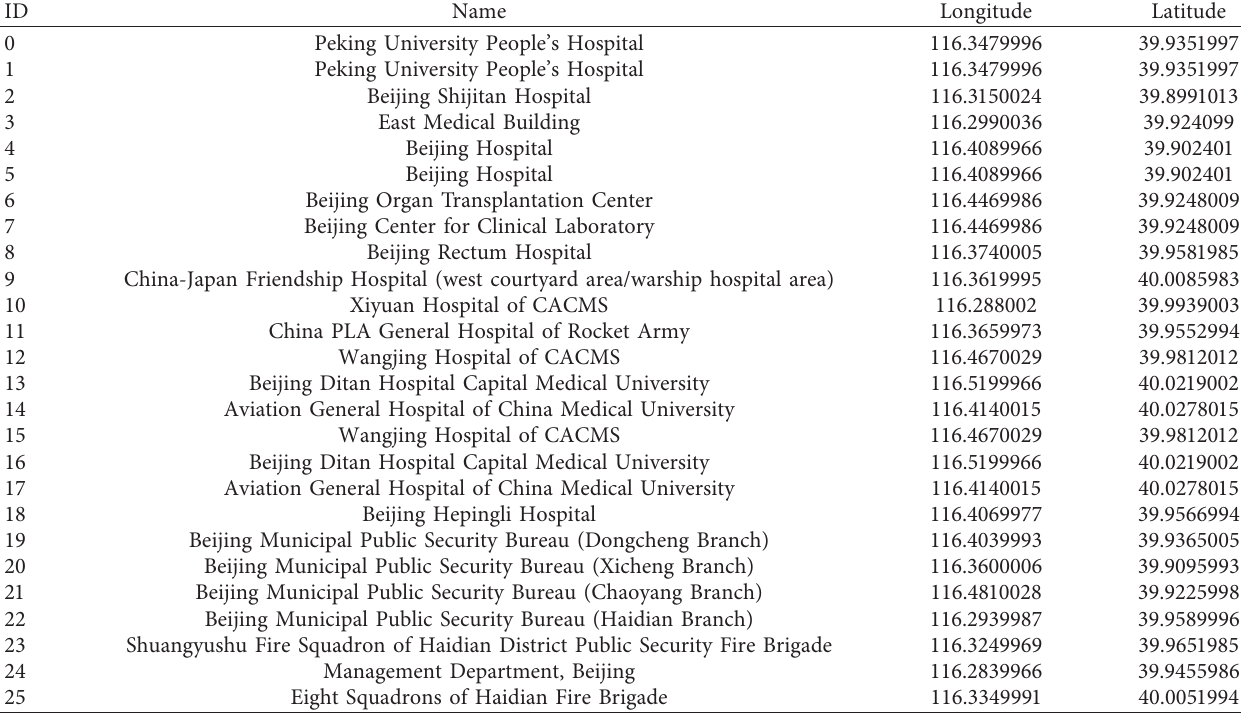
Figure 4: Value of individuals varies with the number of Table 5: Fixed emergency facility locations.